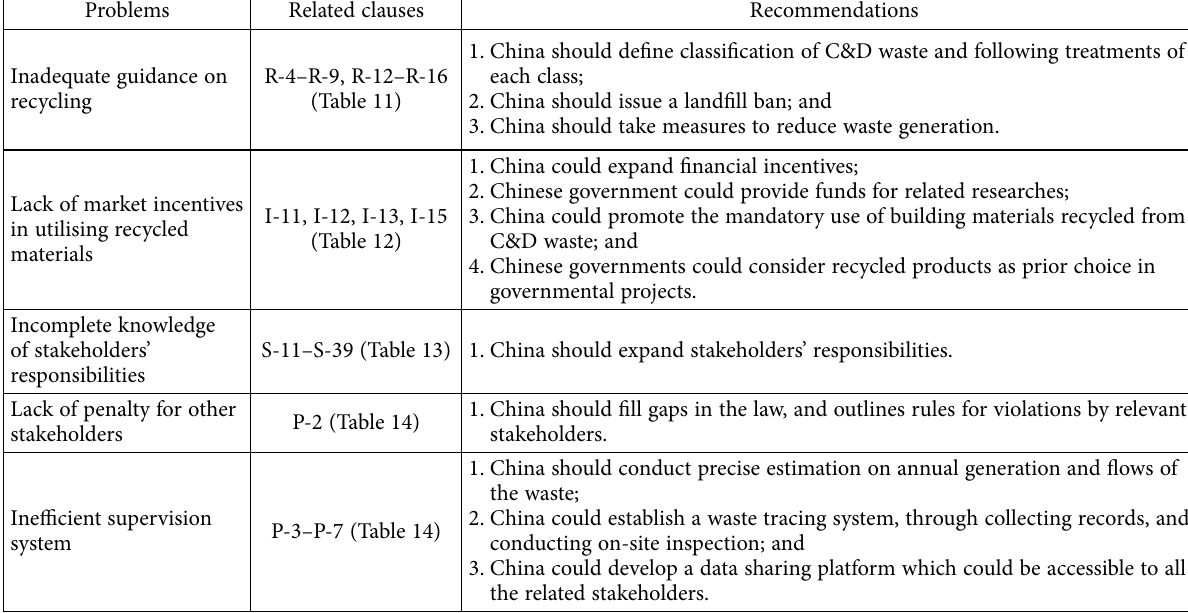
Table 15. Problems and recommendations of the current C&D waste management in China